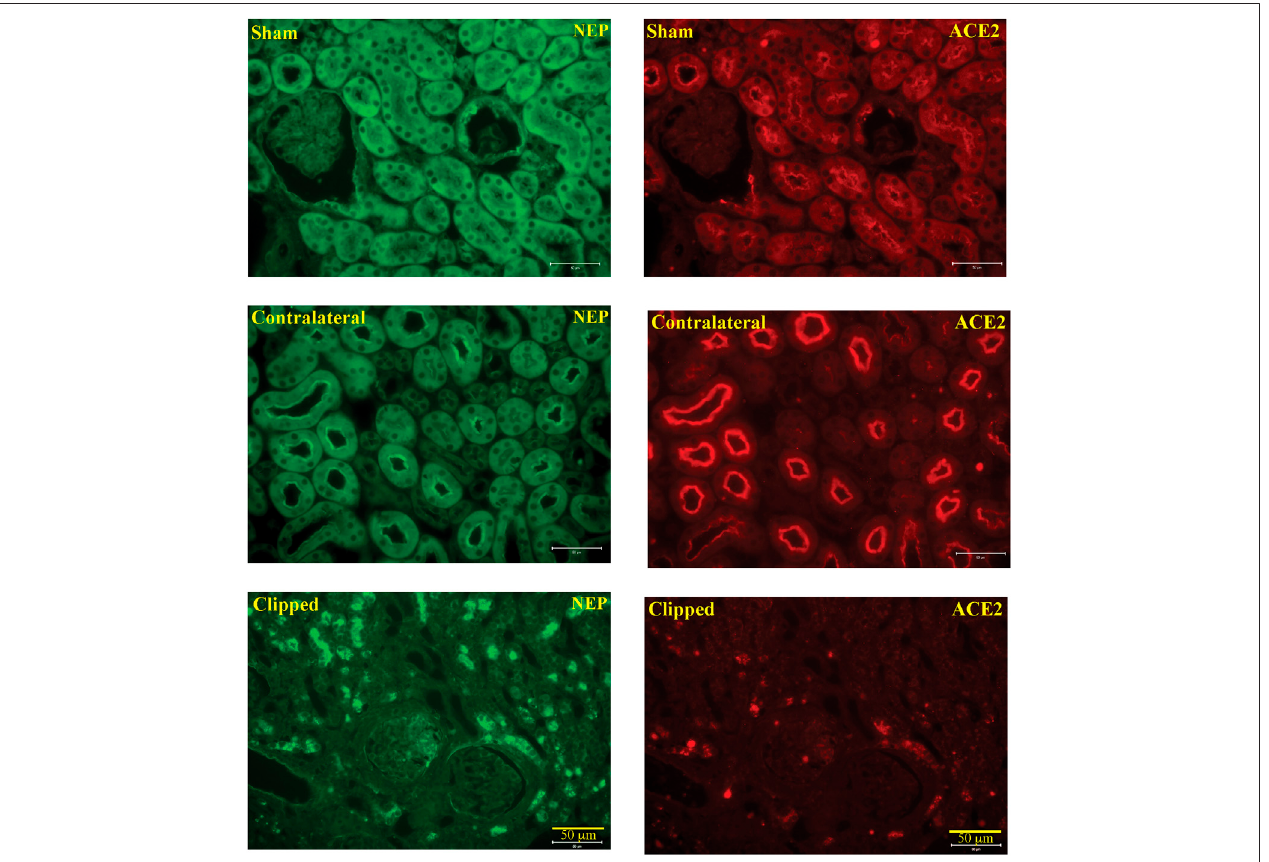
FIGURE 12 | Representative light microscopy images of immuno fl uorescence staining for NEP (FITC, green fl uorescence) and ACE2 (cy3, red fl uorescence) in section of sham, clipped and contralateral kidneys obtained from WT mice. Magni fi cation: × 20, scale bars:50 μ m.